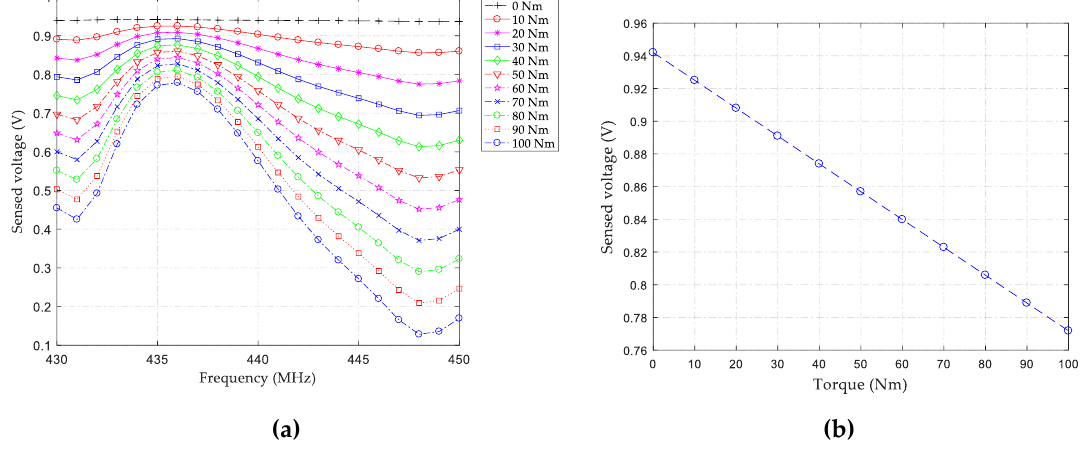
Figure8. Input-outputcharacteristiccurves: ( a )shiftingvoltageamplitudesagainstdi ff erentfrequencies Figure 8. Input-output characteristic curves: (a) Shifting voltage amplitudes against different and torques; ( b ) shifting voltage amplitudes against varying torques at 436 frequencies and torques; (b) Shifting voltage amplitudes against varying torques at 436 MHz.